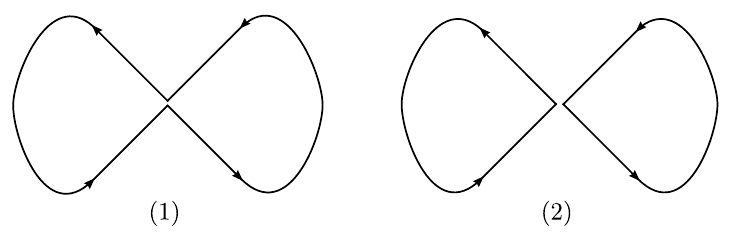
Figure 4 . Sketch of the contours introduced in eq. (3.10). The distances between the cusps merely indicate the ordering around the intersection